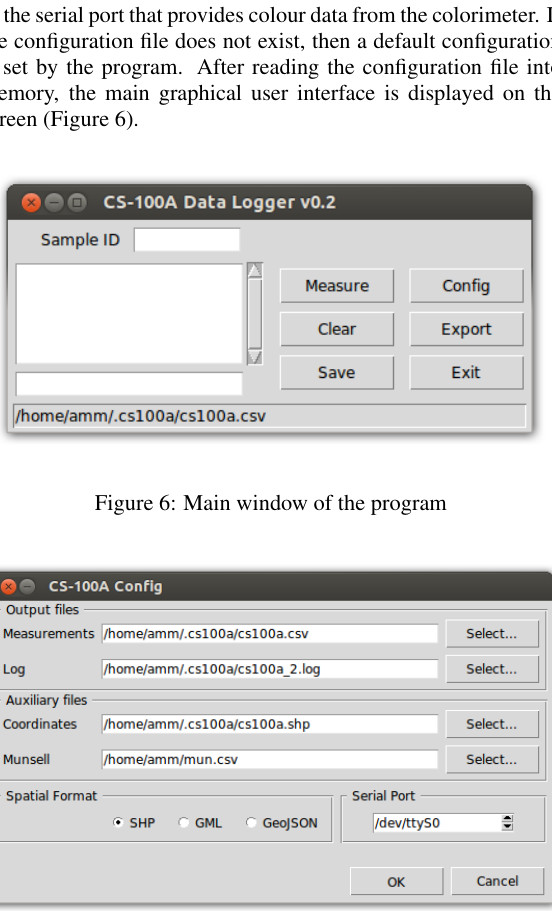
Figure 7: Configuration